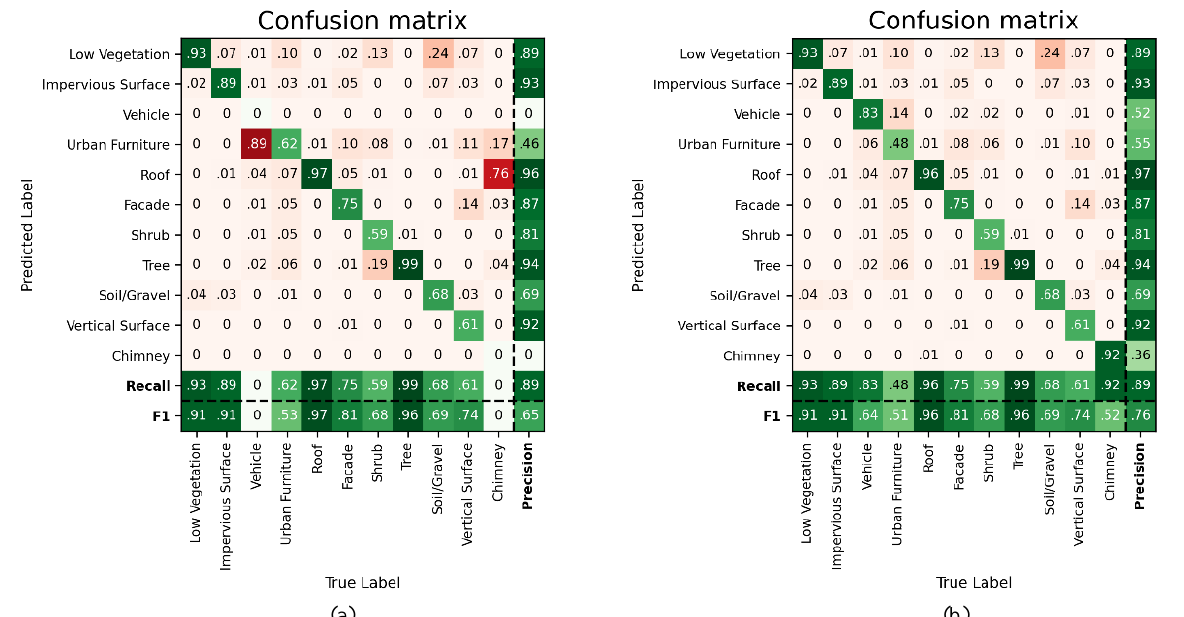
Figure 3. Confusion matrices on (a) the single-stage segmentation (b) our proposed two-stage